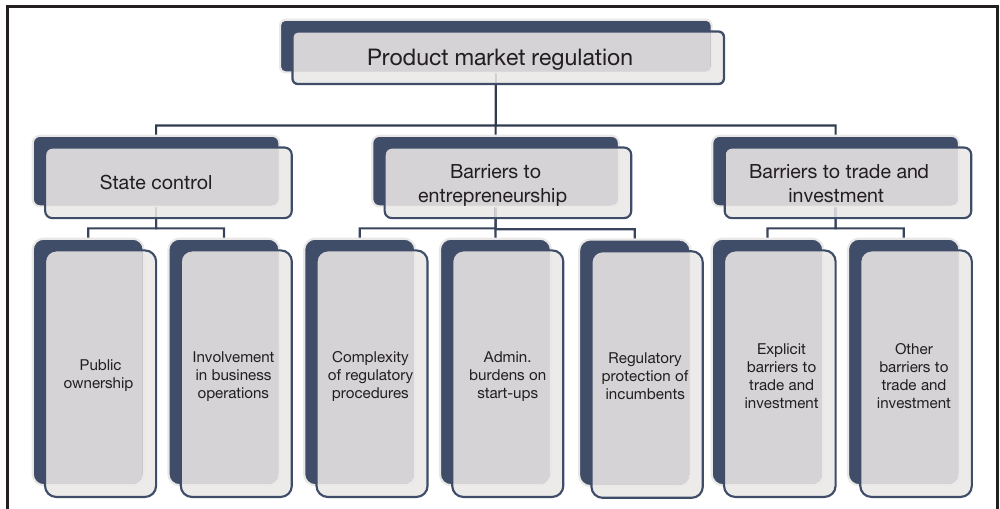
Figure 2 PMR indicator – OECD definition. Product market regulation